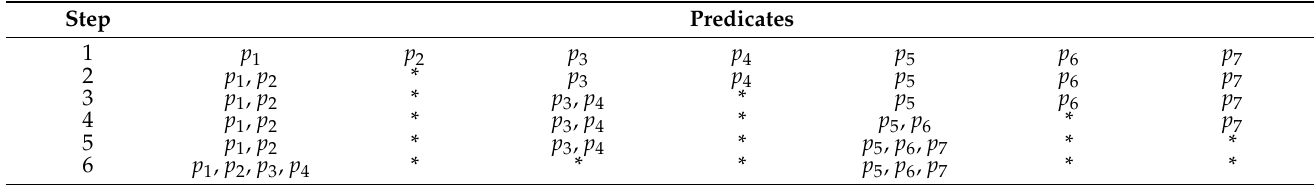
Table 6. Partition Tree for the